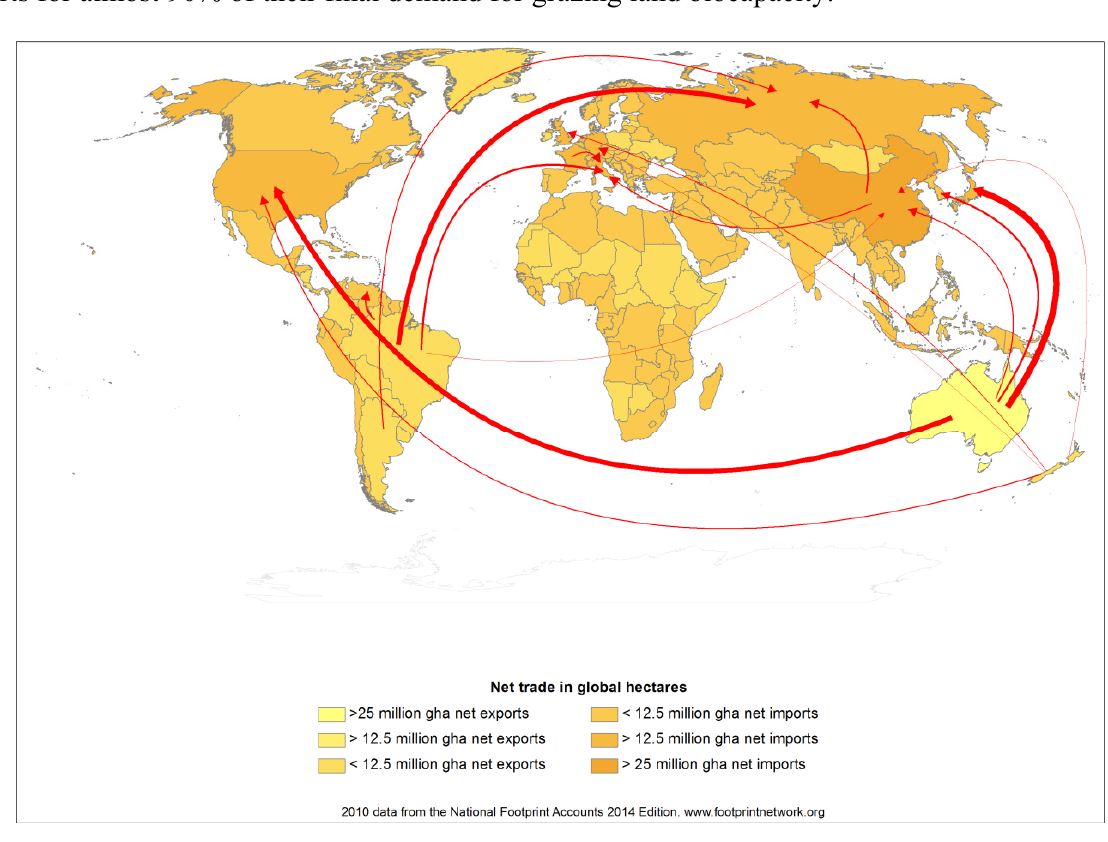
Figure 8. Net trade in grazing land biocapacity: arrows sized by magnitude of embodied biocapacity show the flows into the highest three net importers and out of the highest three net